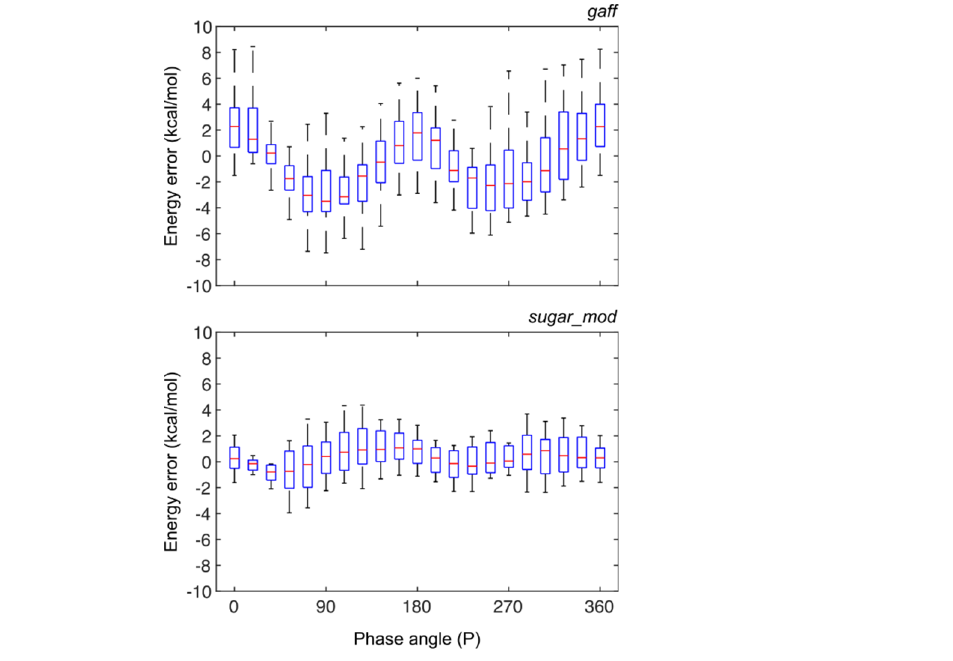
Figure 4. Energy error statistics vs. sugar pucker phase angle (P) for ( top ) gaff force field and ( bottom ) sugar_mod force field parameters. The energy error was calculated as the difference between the average MM energy in 20 ns simulations at specific p values and the respective QM energy; both MM and QM simulations had structures with frozen sugar-heavy atoms. The boxplots show the statistical analysis for structures T = 1–24. On each distribution box, the red central mark indicates the average value ( µ ), the bottom and top edges of the box indicate one standard deviation ( µ ± σ ) and the whiskers extend to two standard deviations ( µ ± 2 σ